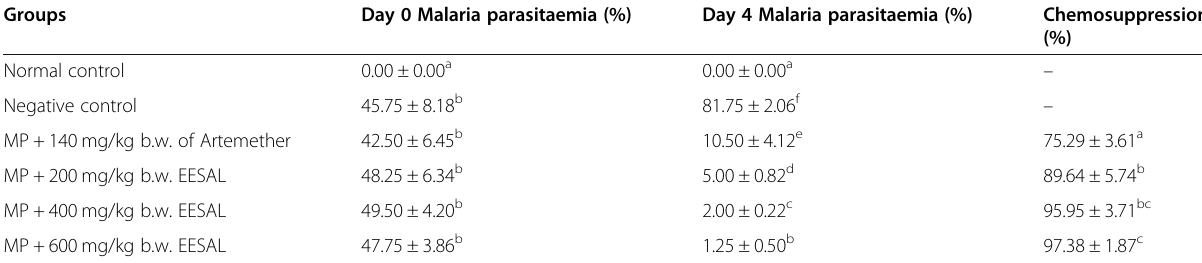
Results are expressed in Means ± SD ( n =6); At p <0.05, mean values with different letters of the alphabets (a, b, c, d … ) as superscripts in a column are statically different while mean values with similar alphabets are not statistically